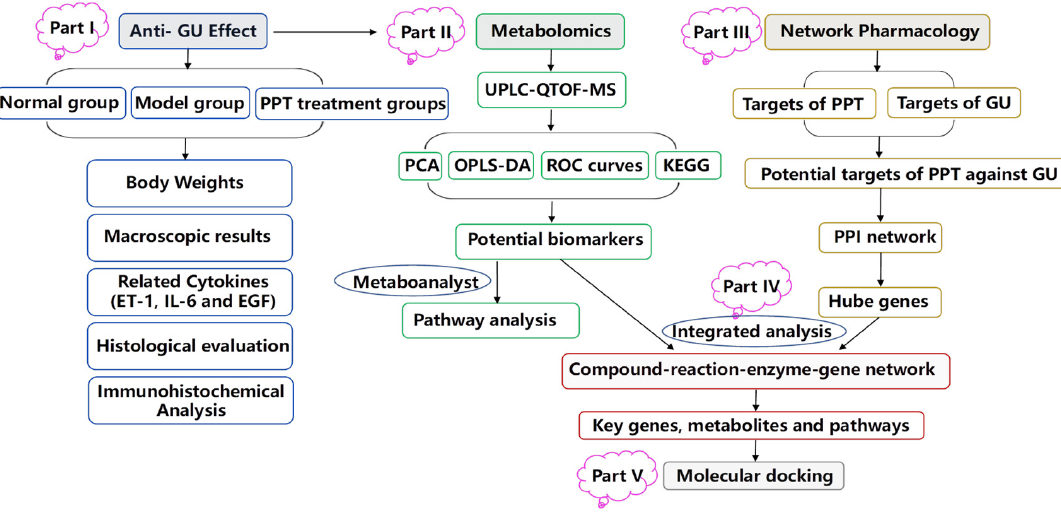
Figure 11. The schematic flowchart of the study.